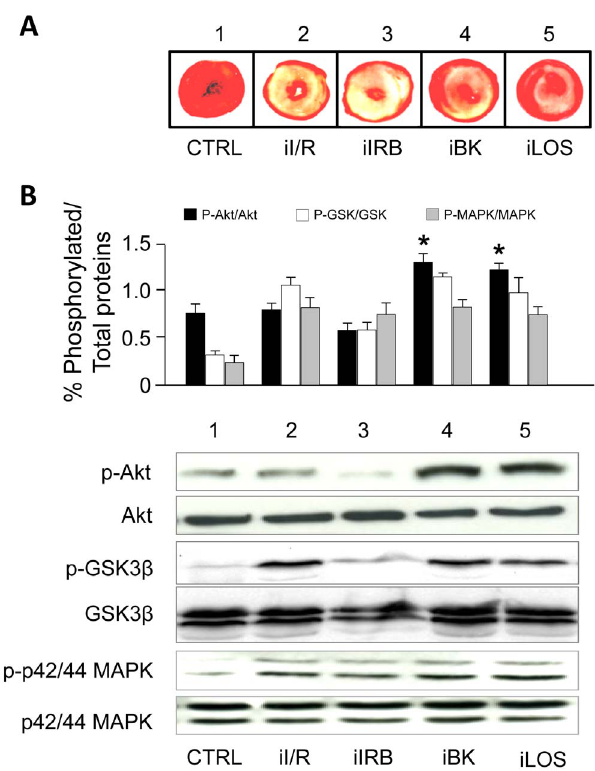
Figure 6. Activation of RISK pathway kinases under post- ischemic intermittent treatments. A . Hearts were cut into transverse slices and stained with TTC to differentiate necrotic (unstained) from viable (red) myocardium. Representative images of each treatment are visualized. B . Hearts were homogenized and lysates immunoblotted for phosphorylated and total isoforms of the indicated proteins. For each experimental condition, the ratios of phosphorylat- ed/total-Akt, phosphorylated/total GSK-3 b and phosphorylated/total p42-44MAPK expressed as the mean 6 SEM of at least 3 independent experiments (each run in triplicate) are shown in the upper panel, and representative immunoblots are shown in the lower panel. A one-factor ANOVA followed by Bonferroni correction analysis was performed.* p , 0.05 vs . iI/R groups. CTRL, non ischemic hearts; iI/R, hearts exposed to ischemia followed by intermittent reperfusion with Krebs; iIRB, hearts intermittently perfused with irbesartan; iBK, hearts intermittently perfused with exogenous BK; iLOS, hearts intermittently perfused with